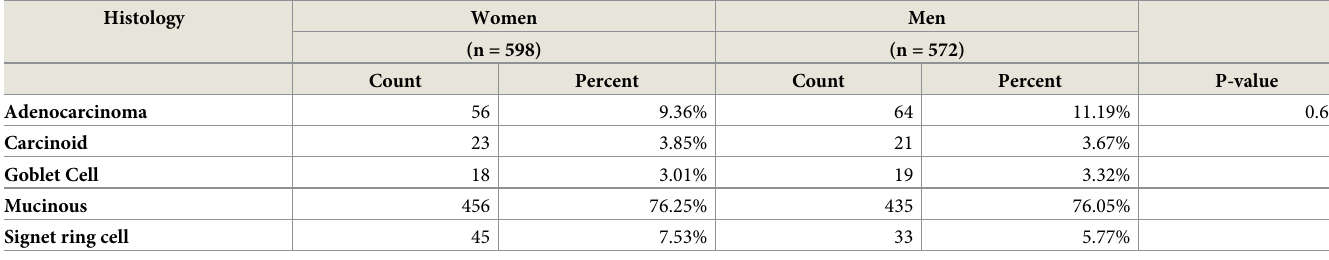
Table 3. Tumor histology of patients undergoing HIPEC and CRS by